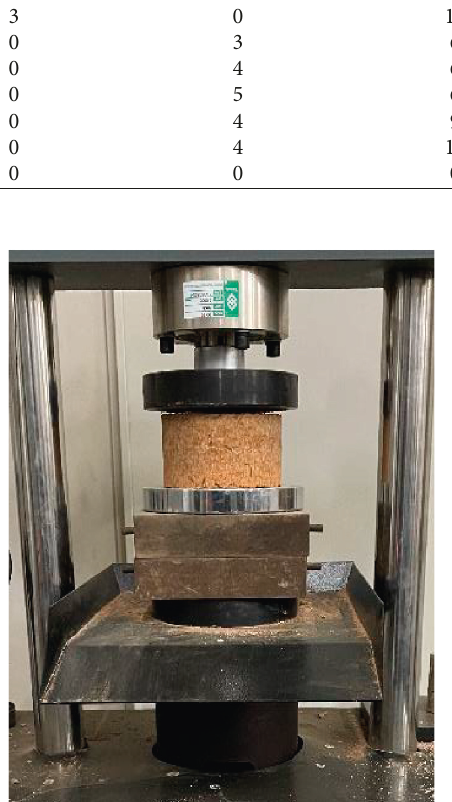
Figure 4: Uniaxial compression test